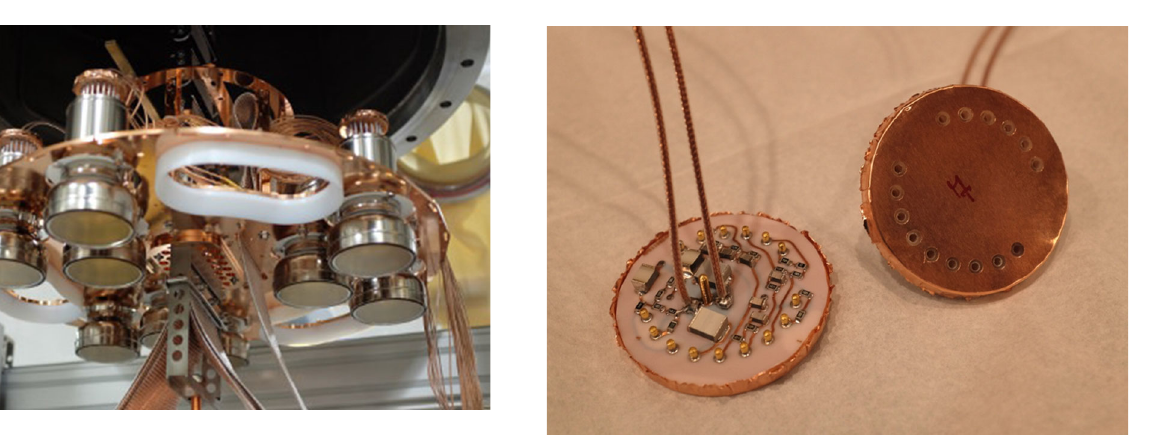
Fig. 10 Top PMT plate with 9 PMTs and three longitudinal slots with PTFE guides for the deployment of the calibration sources